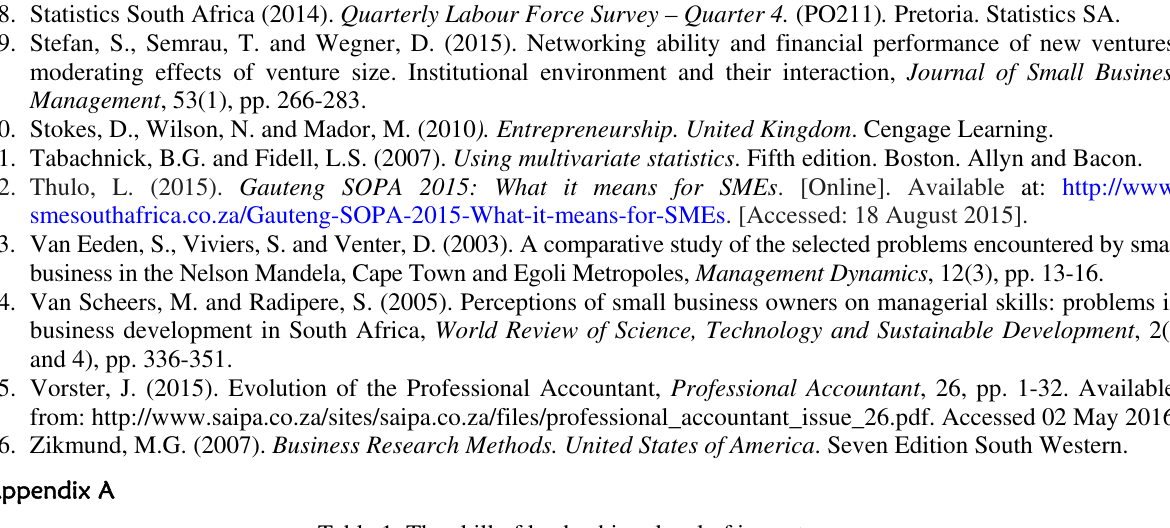
Table 1. The skill of leadership – level of importance